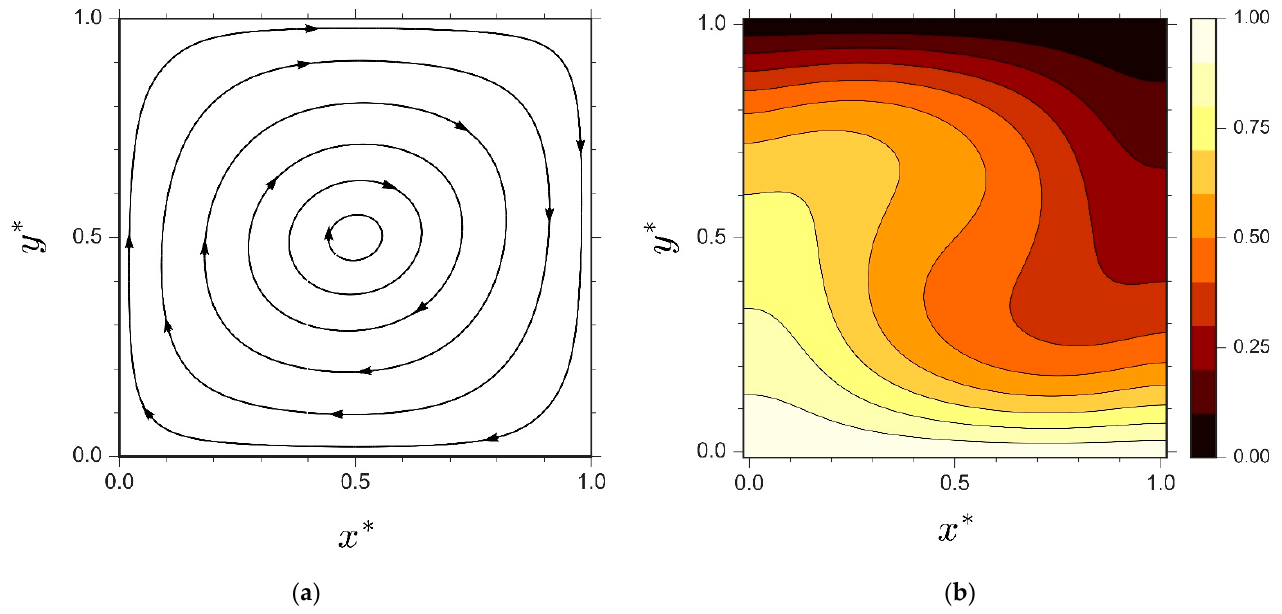
Figure 7. Steady-state flow characteristics of Rayleigh-Bènard convection with aspect ratio = 1, Ra = 10 4 , Pr = 0.71, τ υ = 0.6, and Ma = 0.1 from scenario IIB, displaying ( a ) Streamlines and ( b ) Isotherms contour. Table 4. Average Nusselt number at the hot wall ⟨ Nu ⟩ 0 of the Rayleigh-Bènard convection system from distinct LBM schemes during the steady-state period of the flow for aspect ratio = 1, Ra = 10 4 , Pr = 0.71, τ υ = 0.6, and Ma = 0.1 compared with the outcome of the finite volume method (FVM) [27]. LBM Scheme (Present Study) Simulation Parameter